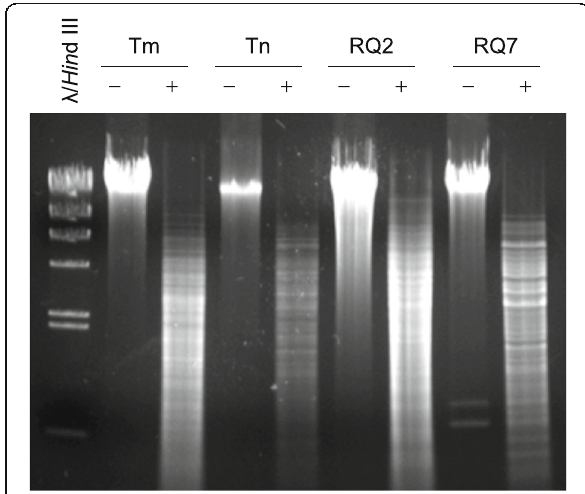
Fig. 9 Digestion of genomic DNA of T. maritima MSB8 (Tm), T. neapolitana DSM 4359 (Tn), T. sp. strain RQ2 (RQ2), and T. sp. strain RQ7 by BstUI. -, negative control, no BstUI; +, treated with